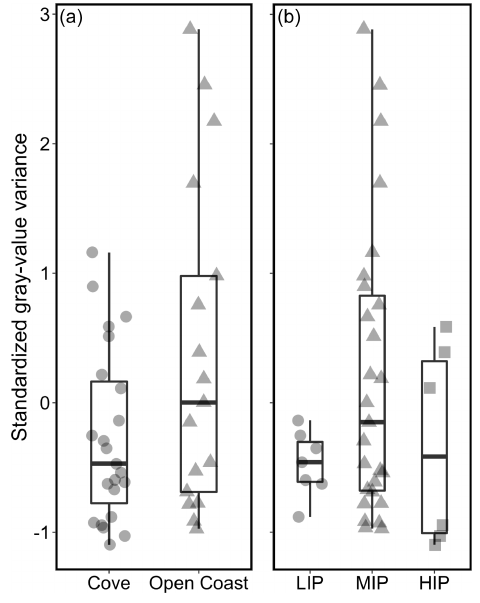
Figure 5. Relationships between micro-habitat and standardized gray-value variance as a proxy for growth band contrast. High stan- dardized gray-value variance is indicative of high contrast between dark and light bands. (a) Cove specimens are from Horseshoe Cove at BMR, and open-coast specimens are from an open-coast site within BMR and Portuguese Beach. (b) Relationships between in- tertidal position (LIP: low intertidal position; MIP: middle intertidal position; HIP: high intertidal position) and standardized gray-value variance for all 40